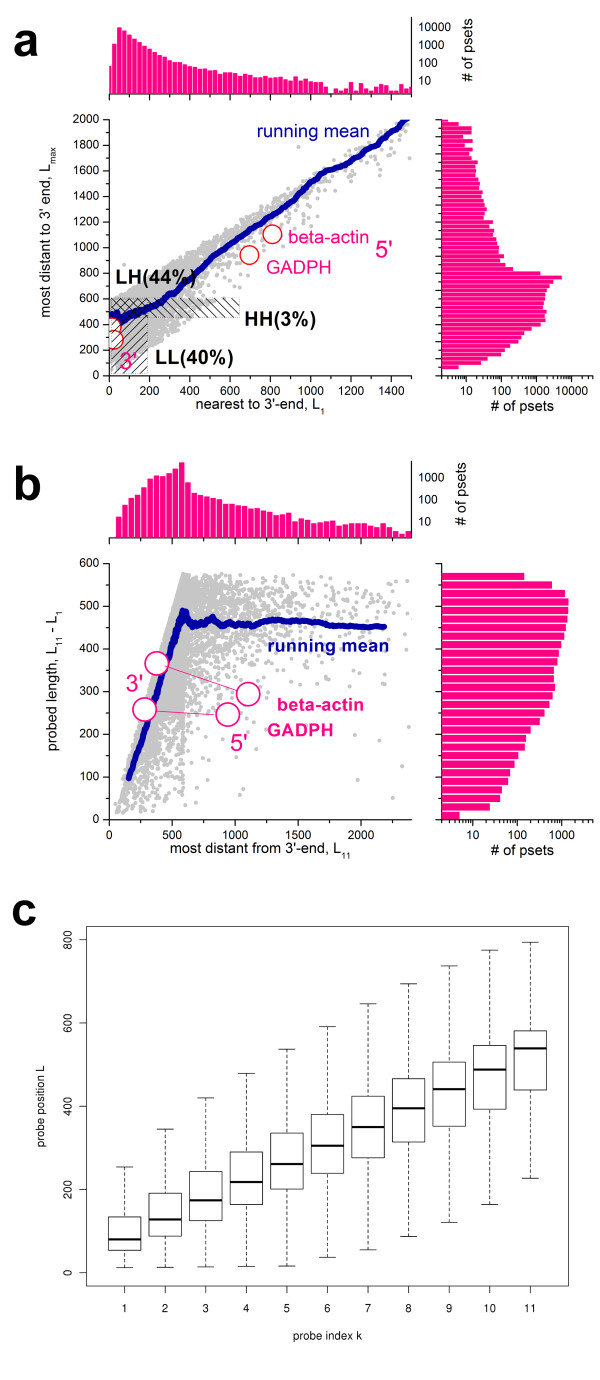
Probe and probe set characteristics of the RAE230 GeneChip array: Panel a correlates the position of the 11th (nearest the 5′ end of the transcripts) and of the 1th (nearest the 3′ end) probe of each probe set and shows the respective number distributions. Most probe sets accumulate in the LH (low L1, high L11) and LL ranges whereas only a few sets are found in the HH range. Panel b shows the coverage size of the probe sets (ΔL = L11- L1) as a function of the position of the 11th probe set together with the respective number distributions. The mean ΔL value nearly linearly increases until k11 ≈ 600 and then it remains virtually constant with ΔL ≈ 460. The most probe sets cover a transcript range of 400 – 550 nucleotides. The open circles refer to the 3′- and 5′-control probe sets. The boxplot in part c correlates the probe index k with the probe position L. The median position per index (see the horizontal bar in each box) nearly linearly increases with k. The slope provides the < ΔL > −value of the array which characterizes the probe sensitivity per index increment (~ 50 nucleotide positions per index increment)